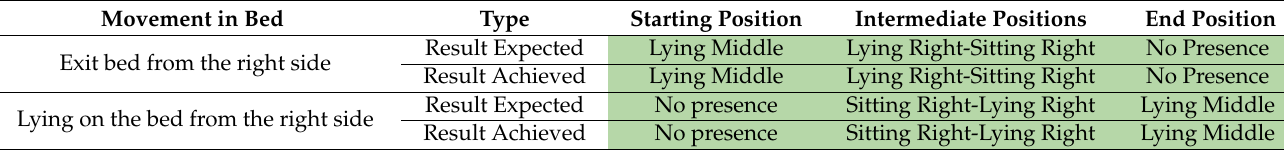
Table 4. Results for a real end user from the El Salvador nursing